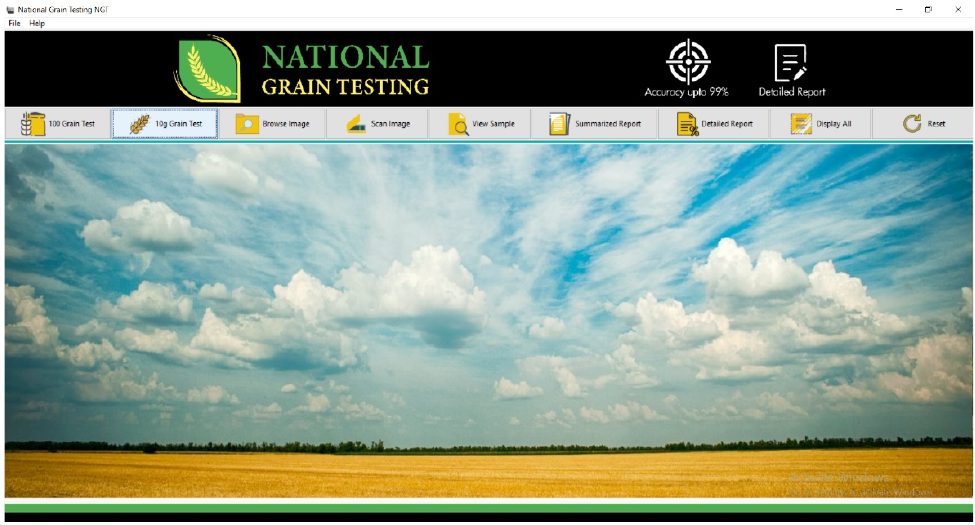
Figure 13. Graphical representation of the predicted and true weight values of the rice kernel.